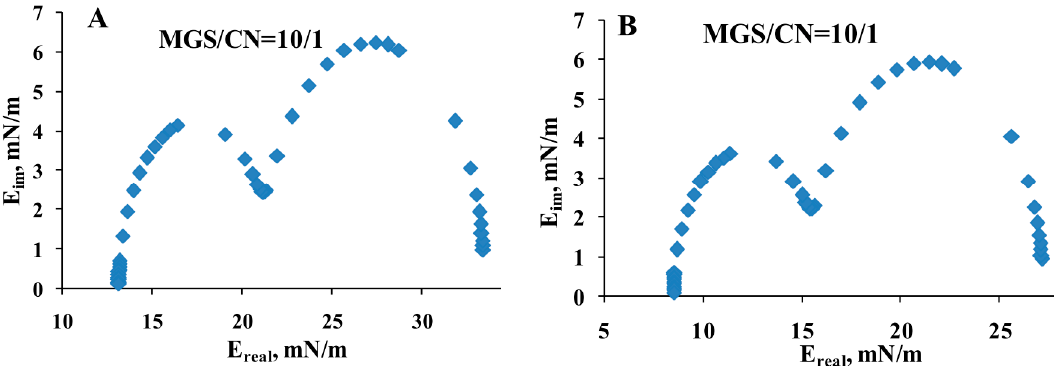
Figure 8. Representative Fourier transformations of typical relaxation transients (( A ) fixed MGS amount; ( B ) constant total lipid).